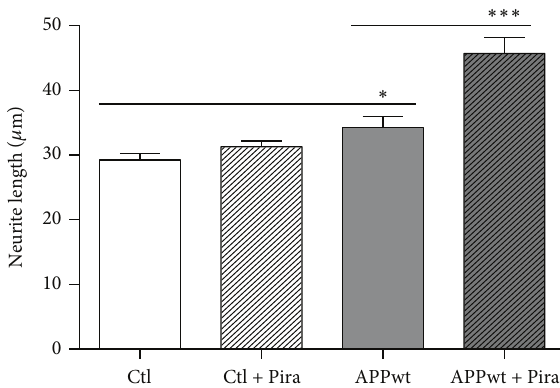
Figure 1: Piracetam improves neurite outgrowth under normal conditions in SH-SY5Y APPwt cells only. SH-SY5Y Ctl cells were seeded and incubated for one day. Afterwards, incubation was started with 1mM piracetam (Pira). After 72 hours, cells were fixed and stained for analysis of neurite outgrowth. In SH-SY5Y Ctl cells, no statically significant effect was observed. In contrast, SH-SY5Y APPwt cells benefit from the incubation with piracetam and possess longer neurites. Data are represented as mean ± SEM; Student’s unpaired 𝑡 -test ( ∗ 𝑝 < 0.05 , ∗∗∗ 𝑝 < 0.001 compared to untreated control cells); 𝑛 =